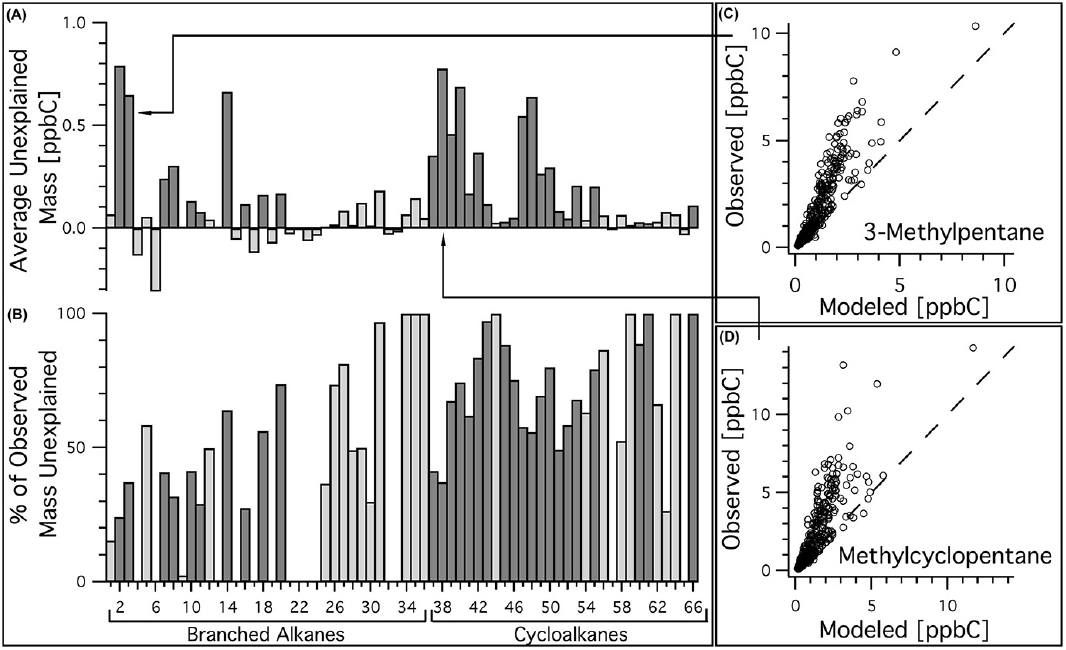
Figure 4. Many branched and cyclic alkanes exceeded predicted concentrations based on source profiles for motor vehicles. (A–B) the average unexplained concentration of each compound and the percentage of unexplained mass out of total observed mass. Compounds that are well correlated (r ≥ 0 . 75 ) with the petroleum gas source are shown with shaded bars. A few compounds have negative residuals. (C–D) Examples of exceedances of observed over-predicted values are shown with a 1:1 line.